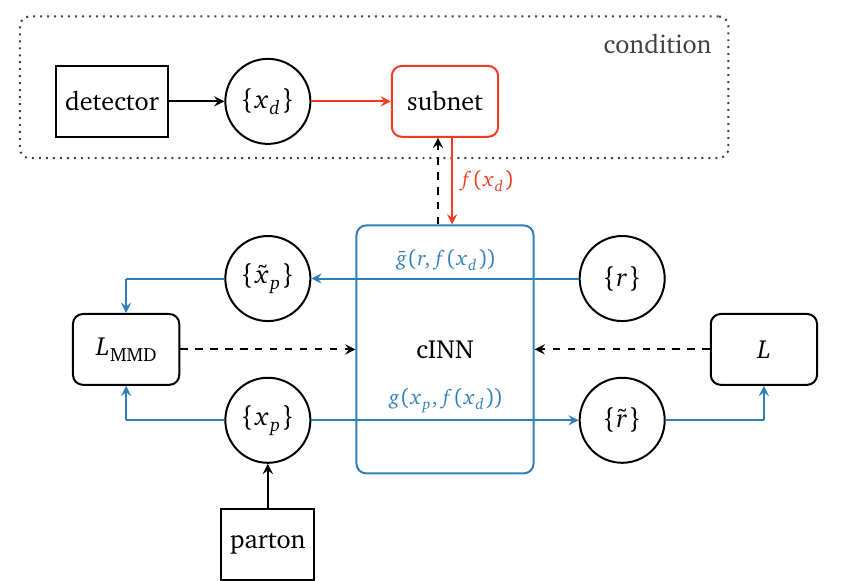
Figure 5: Structure of the conditional INN. The input are random numbers { r } while { x } denote detector-level and parton-level data. The latent dimension loss L fol- d , p lows Eq.(18), a tilde indicates the INN generation.